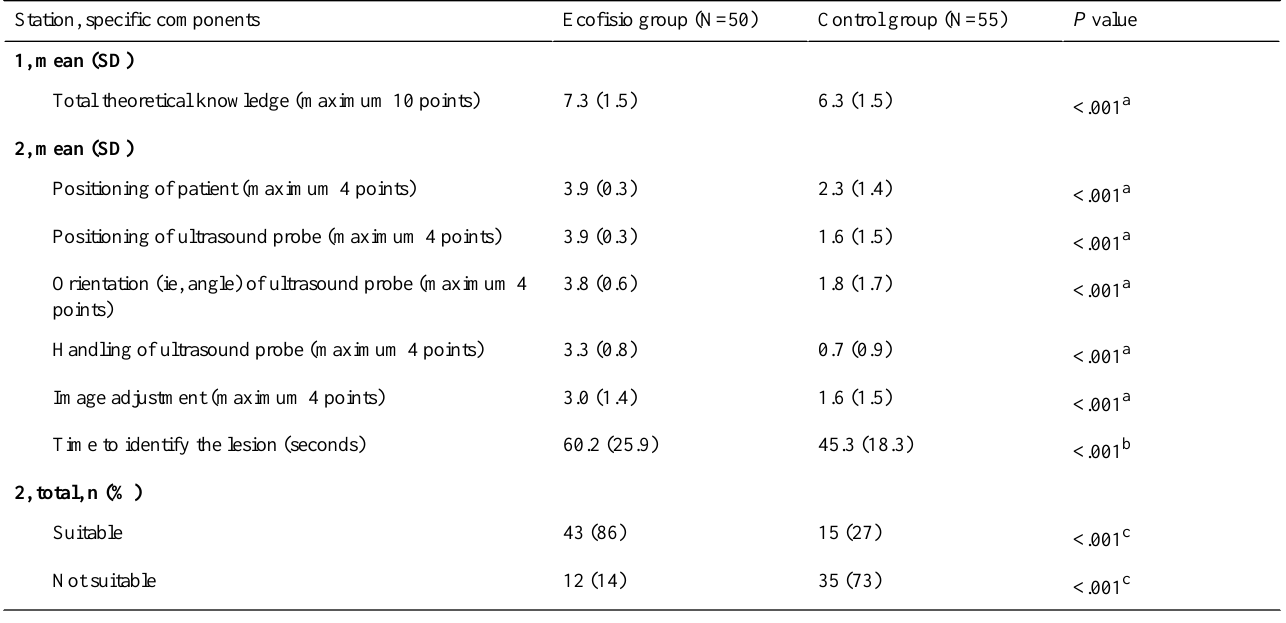
Table 2. Differences between groups in data obtained from the Objective Structured Clinical Examination (OSCE) stations 1 and 2.